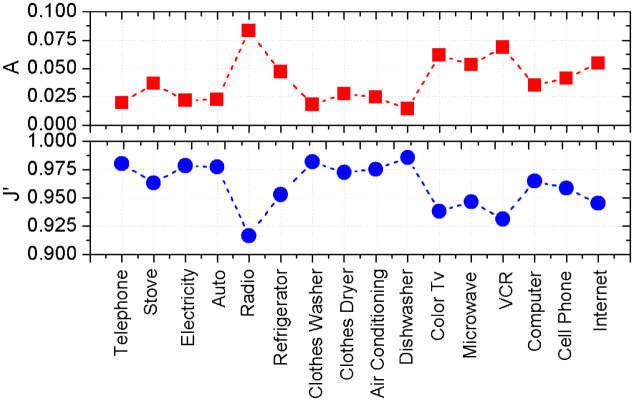
Parameters of the model vs technology.The values of A (top panel) and J′ (low panel) are the result of the best fit of the empirical data with the analytical solution of the model. ω ≃ 1 for all the technologies.